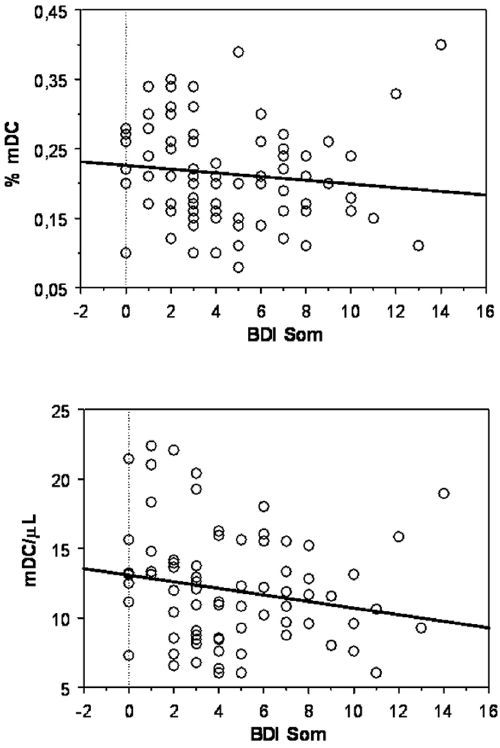
Figure 5. Blood DC association with somatic depression severity in PD. The correlation of BDI SOM scores with percentage values (upper panel) and total counts (lower panel) of mDC present in blood of PD (n=80) subjects is reported in the respective scatter plot, as indicated. Lines represent linear regression.